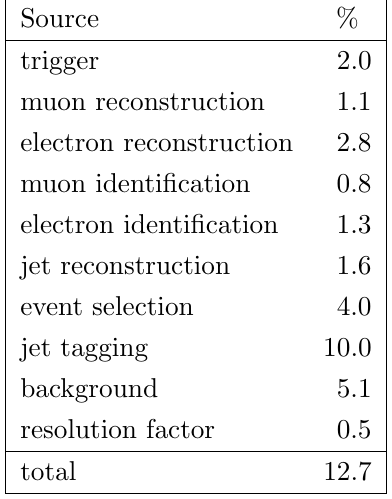
Table 2 . Summary of the systematic uncertainties on the measurement of the t (cid:22) t cross-section in the (cid:12)ducial region de(cid:12)ned by the requirements placed on the leptons and the b -jet, expressed as a percentage of the measured cross-section. An additional uncertainty due to tt modelling is considered when extrapolating to the top quark (cid:12)ducial region.